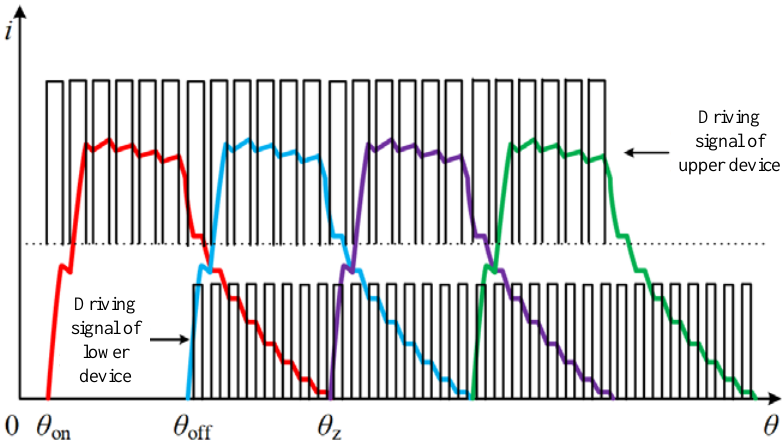
Figure 9. Four phases waveforms of full chopper.